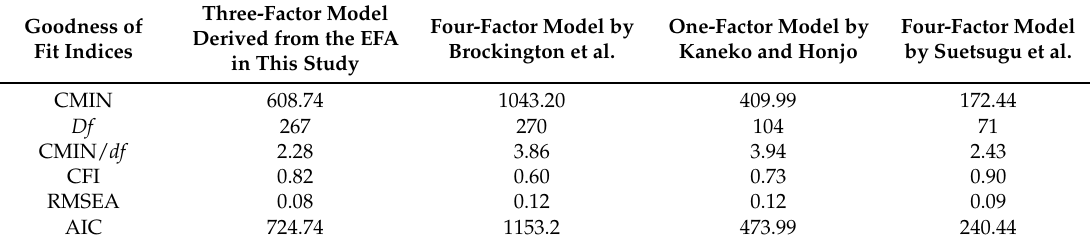
Table 2. Comparison of three models of the PBQ factor structure.